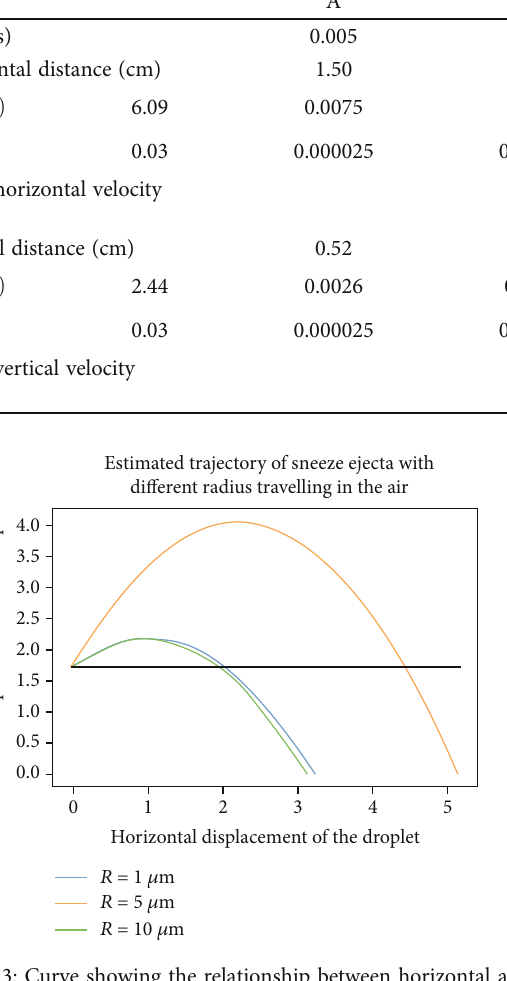
Table 2: Calculation process to get initial horizontal and vertical velocity of the sneeze ejecta after leaving the nasal cavity. A B